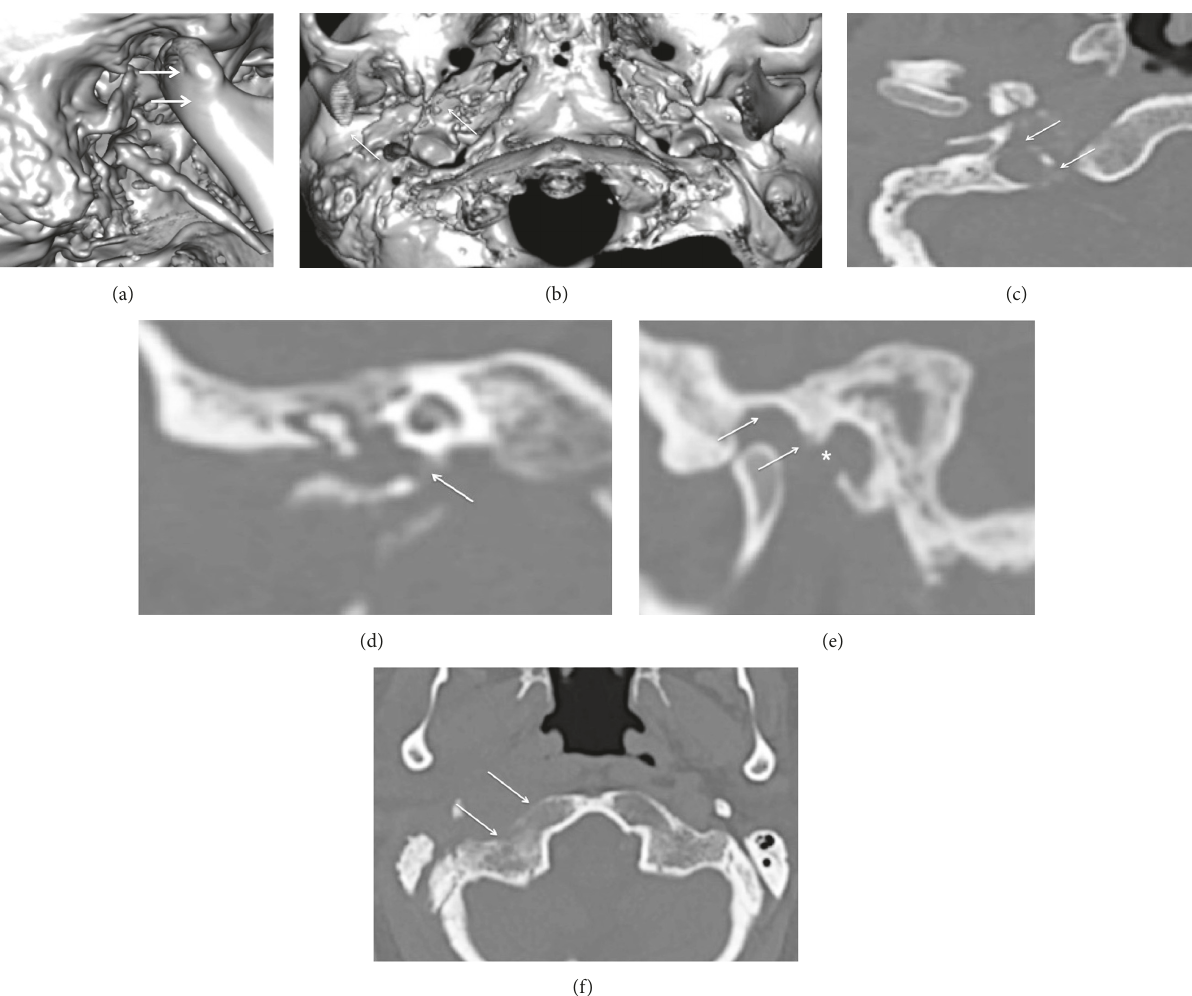
Figure 6: (a) The 3D volume rendering technique shows the lateral surface of the temporal bone: the destruction of the base of the styloid process(vaginalprocess)isclearlyseen.Anteriordislocationofthemandiblewithsubluxationofthecondyleisshownwitharrows.Noteslight cortical erosion of the mastoid process of the right side. (b) Inferior view of the skull base: massive destruction of the petrous and tympanic parts of the temporal bone is marked with arrows. (c) The most severe bone lytic changes were observed around the carotid foramen (arrows). (d) A destruction of the carotid plate is clearly seen on this coronal reformat (arrow). (e) The other possible infection-spreading pathway was from the external auditory canal. Asterisk shows a defect in the anterior wall of the latter. Additionally, arrows show erosion of the mandibular fossa roof as well as auricular tubercle. Note an anterior dislocation of the mandibular condyle. (f) Axial CT scan shows the destruction of the cortical layer of the occipital bone